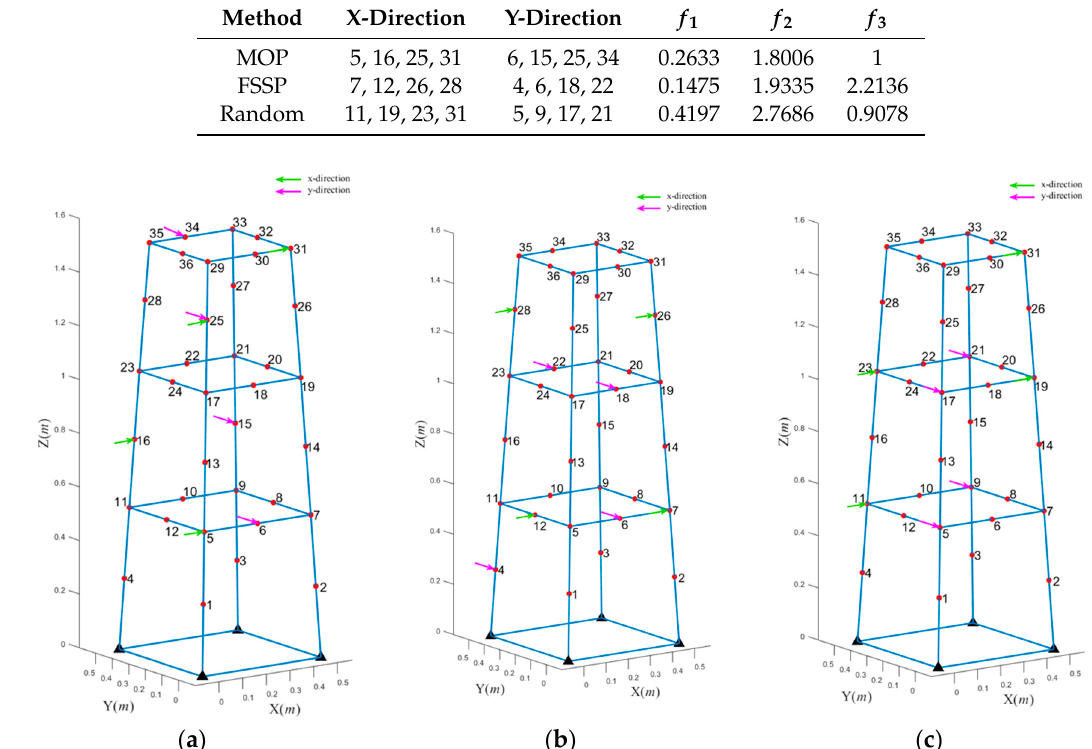
Table 5. Sensor placement and performance evaluation for the three OSP methods.